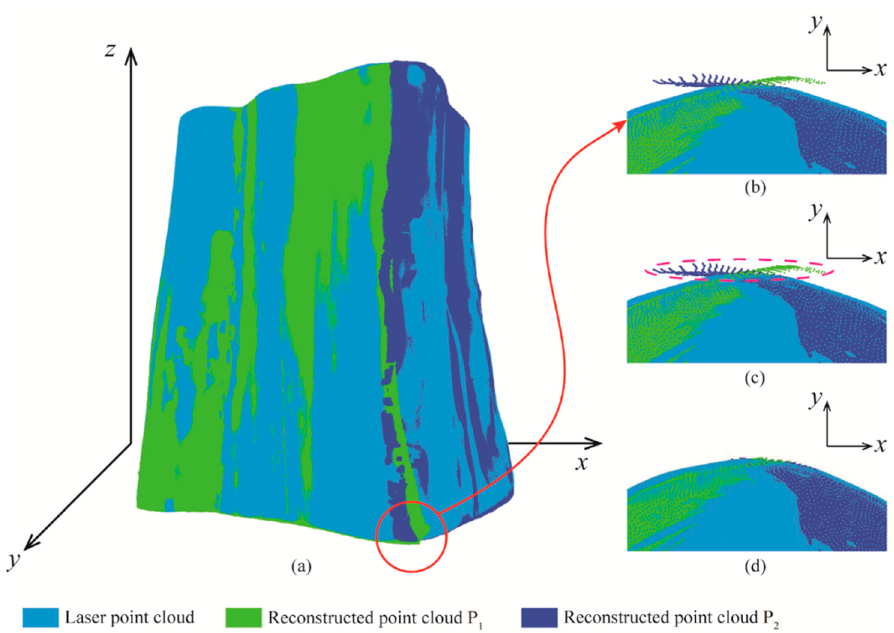
Figure 2. Point cloud merging example. ( a ) A reconstructed surface with partially overlapping. ( b ) The elevation view of the red part, with local overlap of the data. ( c ) Identifies the overlapping areas and finds points within the overlapping areas which are far from the laser point cloud. ( d ) The result after removing the overlapping points. Algorithm 4 Determining full-field displacements from three-dimensional shape recon- struction.